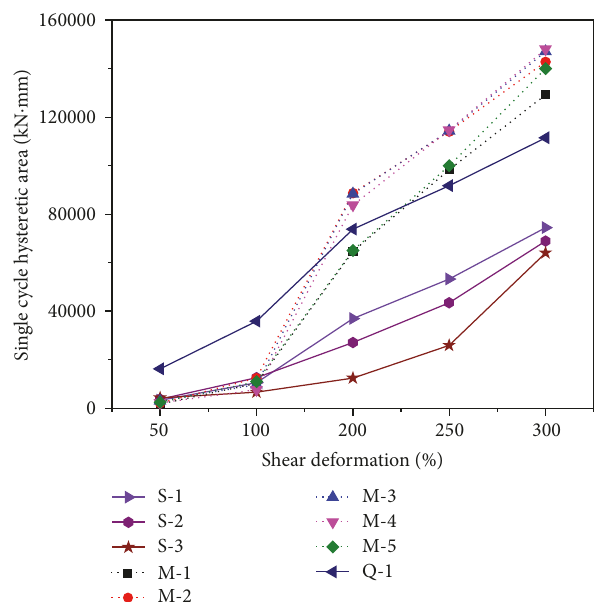
Figure 11: Shear deformation and energy dissipation curve.